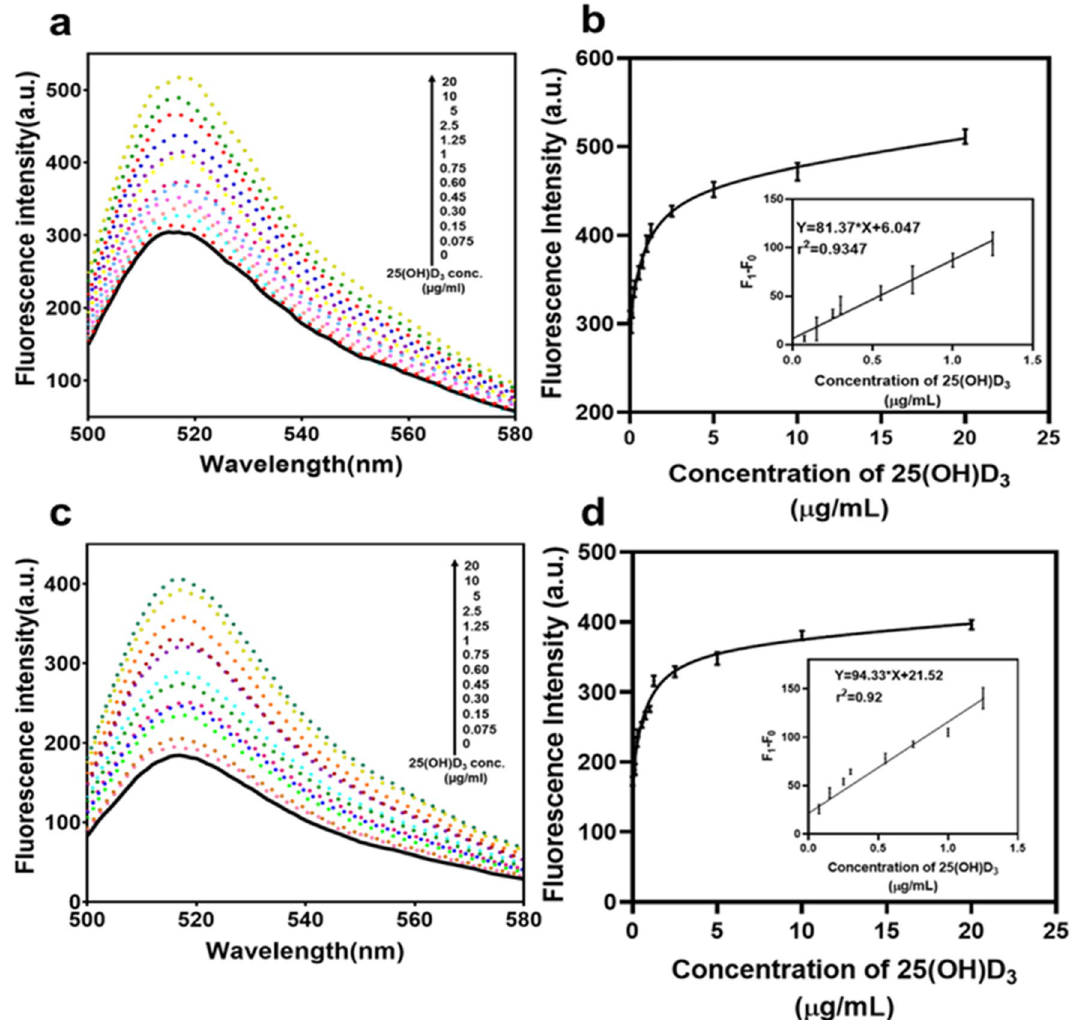
Figure 6. Evaluation for 25(OH)D 3 detection in Mice serum. ( a , b ) Fluorescent spectrum and fluorescent intensity of real time samples analysis using 50% mice serum spiked up samples with 25(OH)D 3 using GO Inset: Peak fluorescence change shows a linear relationship (0–1.25 µg/mL) with 25(OH)D 3 concentration. ( c , d ) Fluorescent spectrum and fluorescent intensity of real time samples analysis using 50% mice serum spiked up samples with 25(OH)D 3 using GO-COOH Inset: Peak fluorescence change shows a linear relationship (0–1.25 µg/mL) with 25(OH)D 3 concentration. (Apt –100 nM, GO and GO-COOH-50 µg/ mL) F0: Aptamer + GO ( b ) and Aptamer + GO-COOH ( d ); and F1: Apt + GO + 25(OH)D 3 ( b ) and Apt + GO-COOH + 25(OH)D 3 ( d